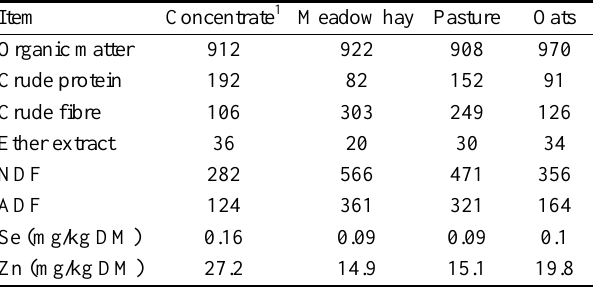
Table 1. Chemical composition of feeds (g/kg